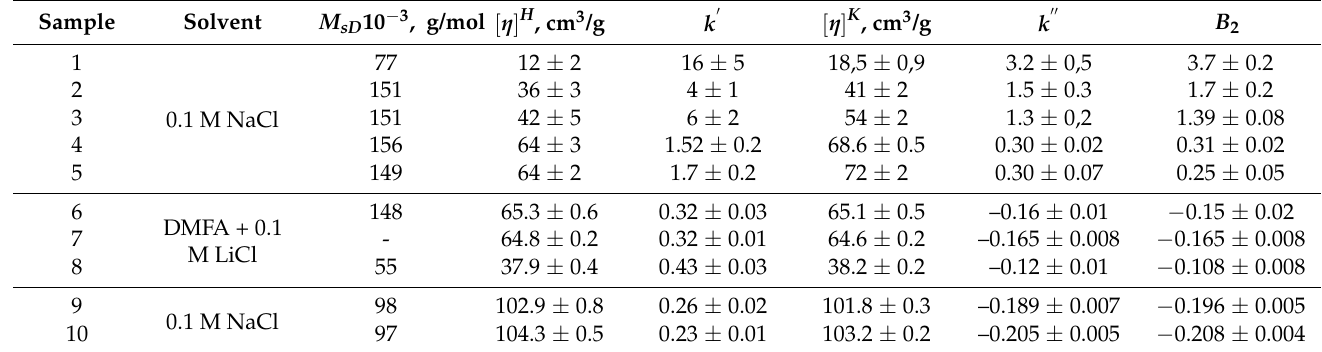
Table 4. The molecular masses M sD , the values of intrinsic viscosities, obtained from Huggins ( [ η ] H ) and Kraemer ( [ η ] K ) plots and Huggins ( k (cid:48) ) and Kraemer ( k (cid:48)(cid:48) ) parameters, for MVAA- co -MVAC 12 H 25 in aqueous 0.1 M NaCl (Samples 1–5) and DMFA + 0.1 M LiCl (Samples 6–8); MVAA- co -MVAC 6 H